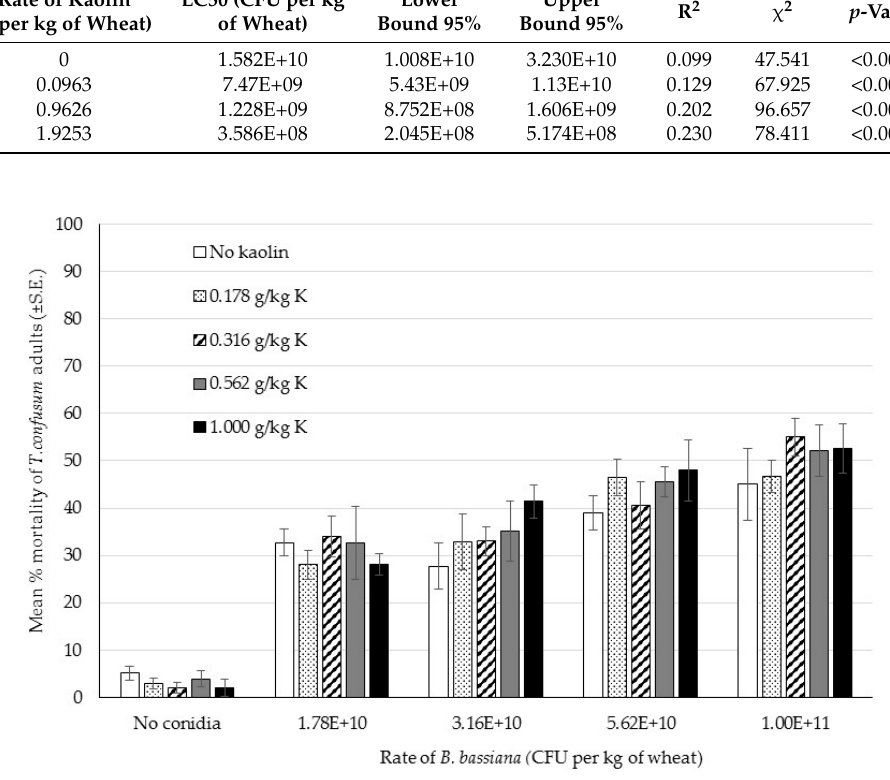
Figure 3. Bioassay 3: Percentage mortality of Tribolium confusum adults exposed to different rates